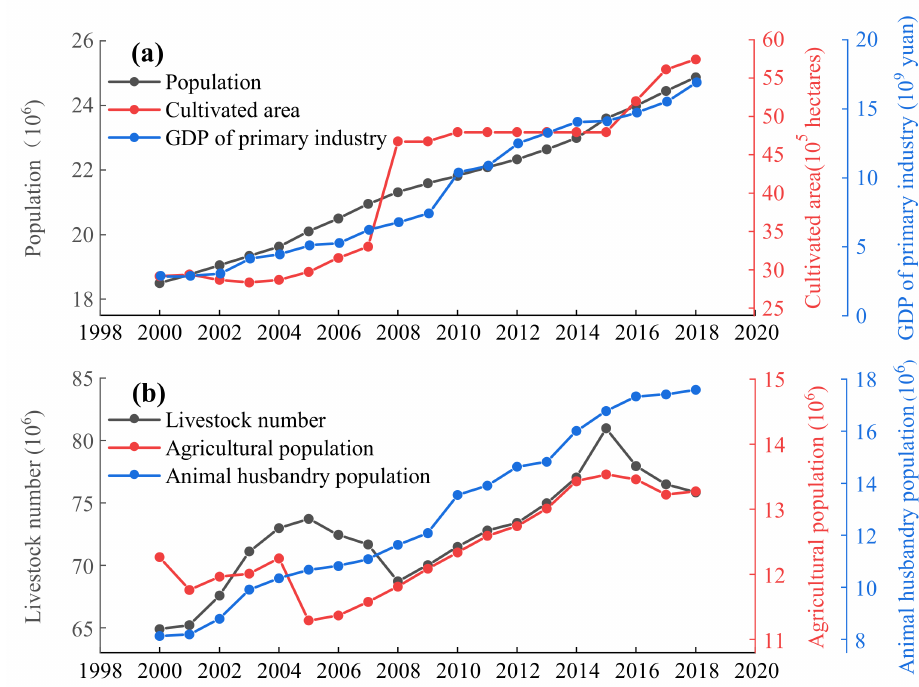
Figure 12. Change trend of human factors in Xinjiang from 2000 to 2018. ( a ) population, cultivated rea and GDP of primary industry; ( b ) livestock number, agricultural population and animal husbandry population.